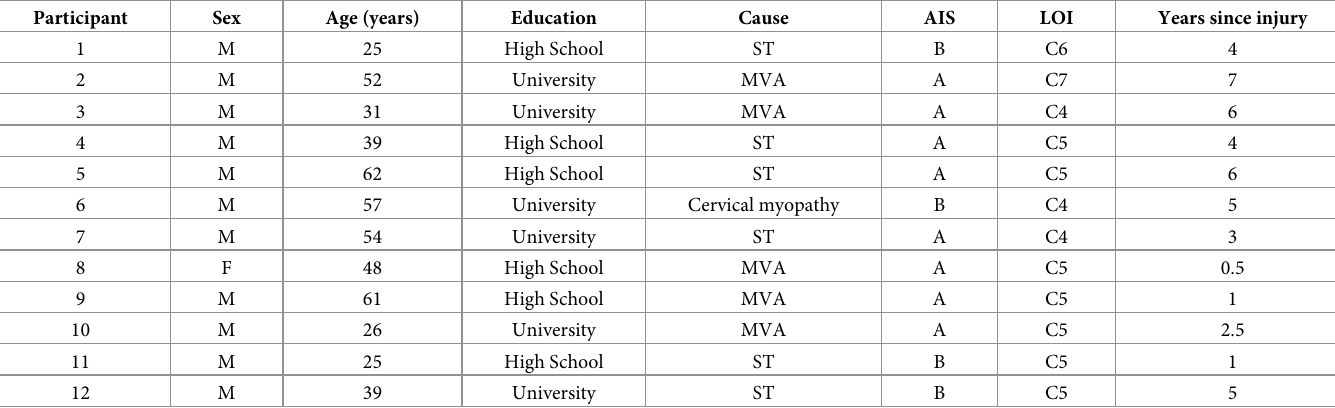
Abbreviations: AIS, American Spinal Injury Association Impairment Scale; LOI, level of injury as assessed by the International Standards for Neurological Classification of Spinal Cord Injury (ISNCSCI); MVA, trauma in motor vehicle accident; ST, trauma during sport or recreation activity. High school = graduated from high school; University = undergraduate degree at least.